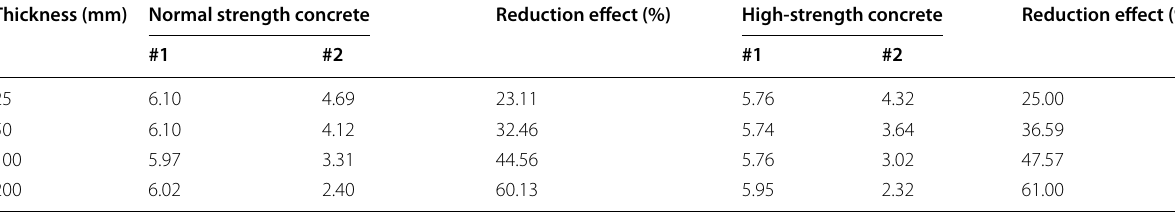
Table 9 Results of parametric study on blast‑proof panel thickness Thickness (mm) Normal strength